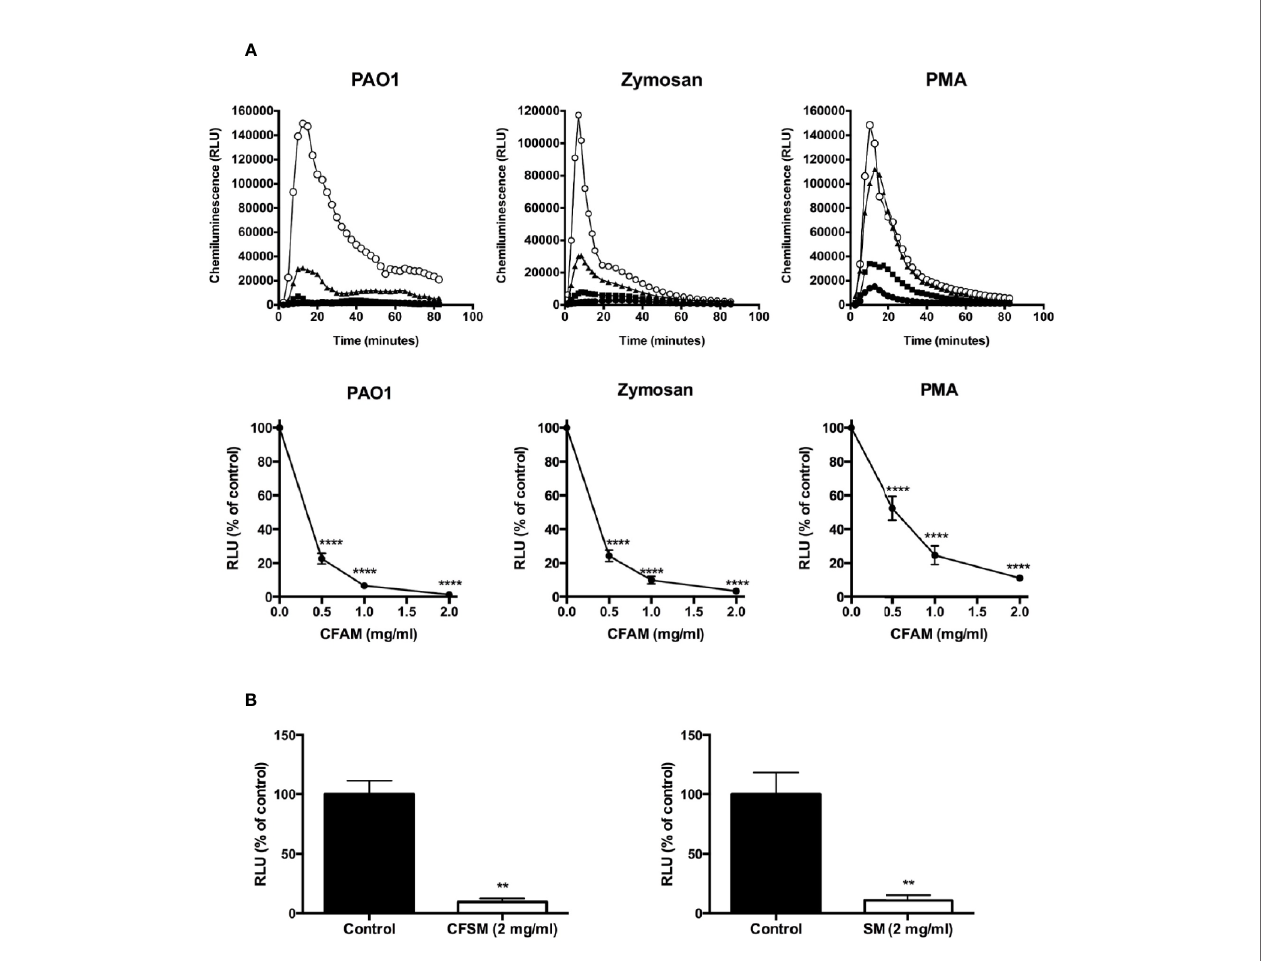
FIGURE 3 | Mucin suppression of intracellular chemiluminescence in neutrophils activated by opsonized PAO1 bacteria, opsonized zymosan and PMA. (A) . Neutrophils isolated from the peripheral blood of healthy volunteers were incubated with opsonized PAO1 at a bacteria:neutrophil ratio of 2:1, 2.5 mg/ml of opsonized zymosan, or 1 µg/ml of PMA. Luminol-enhanced chemiluminescence in the presence of superoxide dismutase and catalase was measured over time in a luminometer. (Top row: open circles = no CFAM; triangles = CFAM, 0.5 mg/ml; squares = CFAM, 1 mg/ml; closed circles = CFAM, 2 mg/ml). The bottom row shows the mean ± sem of the maximal RFU data points recorded in repeated experiments. (n = 4 experiments, **** P < 0.001 vs. no mucin). (B) Mucins derived from the saliva of CF (CFSM) and non-CF (SM) individuals also suppressed neutrophil chemiluminescence in the presence of opsonized PAO1 bacteria (n = 3 experiments, **p < 0.01 vs. non